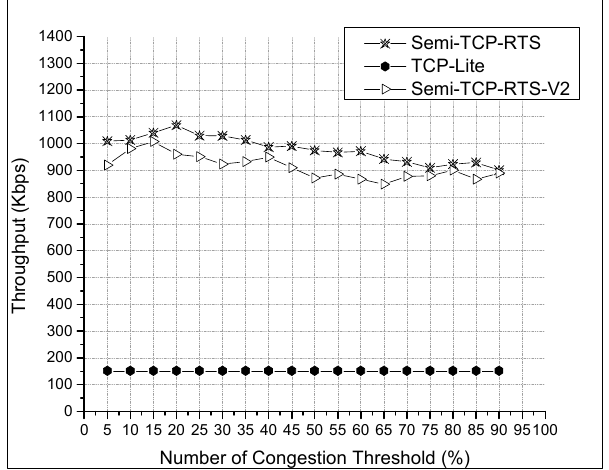
Figure 7. Throughput with various CTh settings in a congestion network.